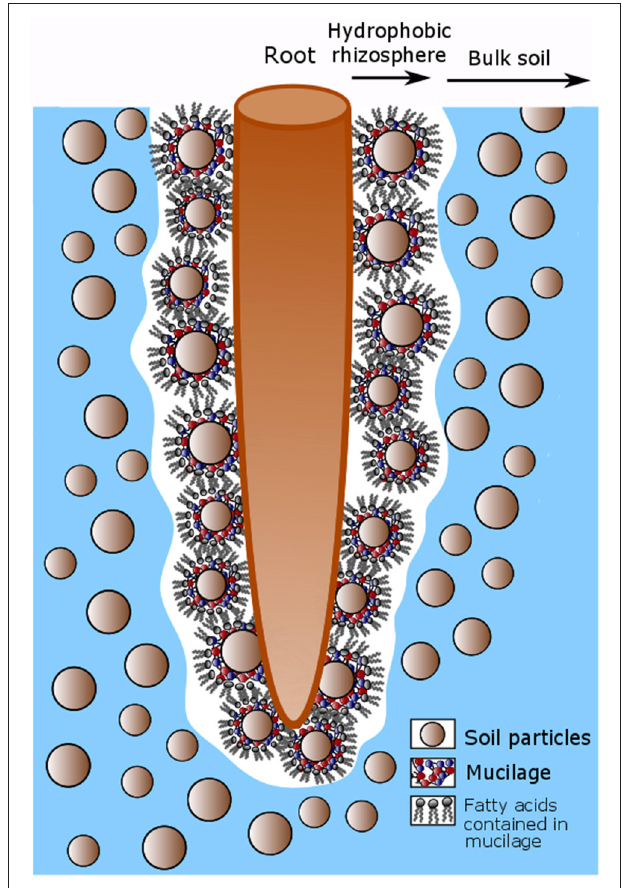
FIGURE 2 | Conceptual model describing the hydrophobicity around root after soil drying caused by fatty acids contained in mucilage. Mucilage is released by the root tip and accumulates around soil particles in the rhizosphere. Upon soil drying the fatty acids contained in mucilage turn their hydrophobic tails outwards so that the soil around the root becomes